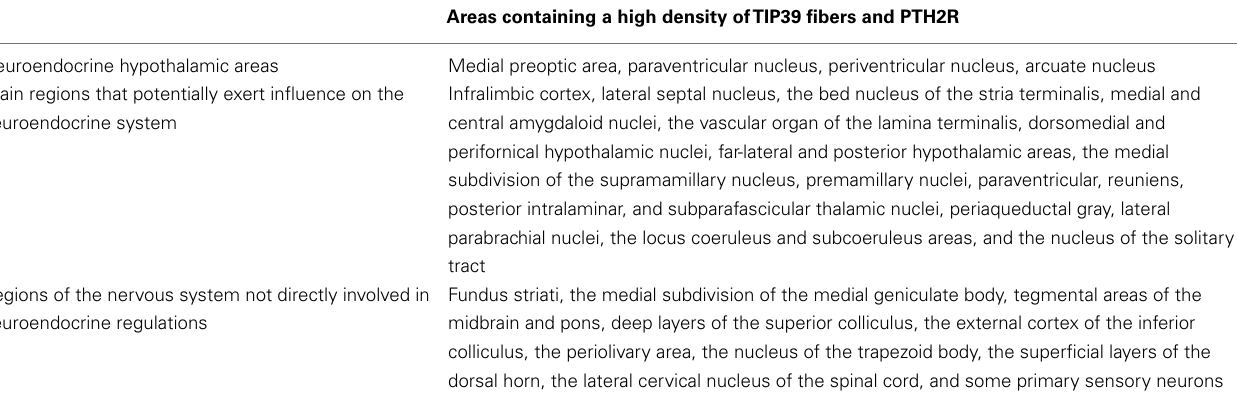
Table 1 |The distribution ofTIP39 axon terminals and the PTH2R in the nervous system. Areas containing a high density ofTIP39 fibers and